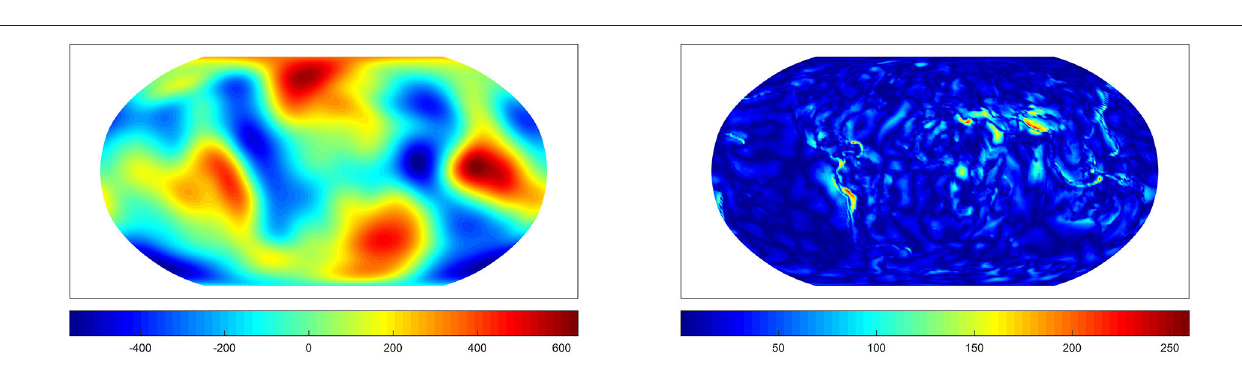
FIGURE 14 | The approximation from the ROFMP for the parameter chosen by the GCV (Left) and the difference to the EGM2008 up to degree 100 (Right) . Values in m 2 / s 2 . The inefficiency amounts to 1.14.